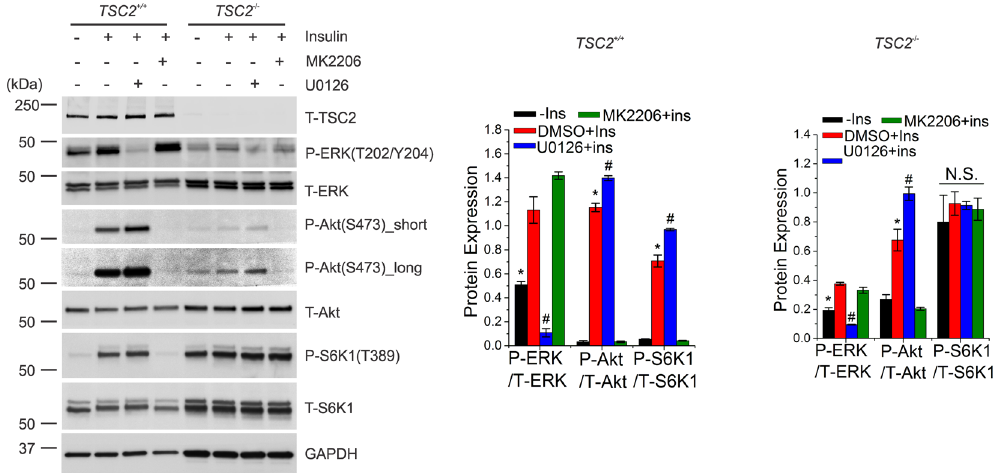
Figure 3. Insulin regulates ERK activity in both Tsc2 + / + and Tsc2 − / − cells. Tsc2 + / + and Tsc2 − / − MEFs were starved of serum (16 h) and treated with the indicated drugs for 2 h prior to insulin stimulation (1 µ M, 15 min). Lysates were analyzed by immunoblot assay using antibodies as indicated. GAPDH was used as a loading control in all immunoblot assays. Quantification of three independent experiments is reported in the bar diagrams. All quantitative analyses are reported as mean ± SEM with a significance level of * p < 0.05 and # p < 0.05. N.S. indicates not significant. * and # indicate significant differences between all conditions in each group. Cropped blots from full-length gels are